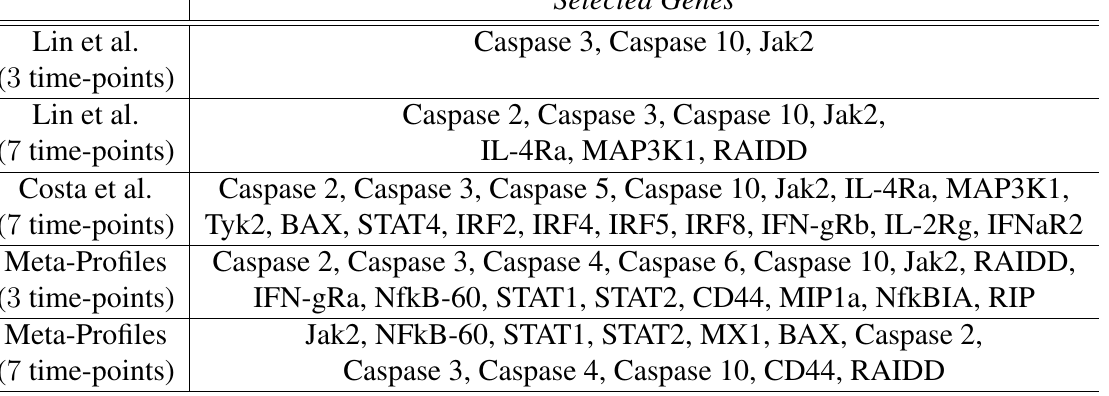
Table 4: Selected genes in [4, 5] versus most discriminative genes used in the meta-profiles classifier. Selected